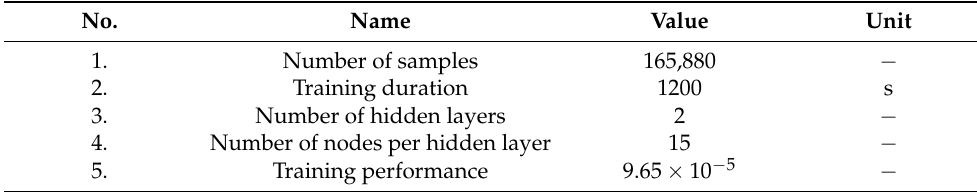
Table 7. Neural network model